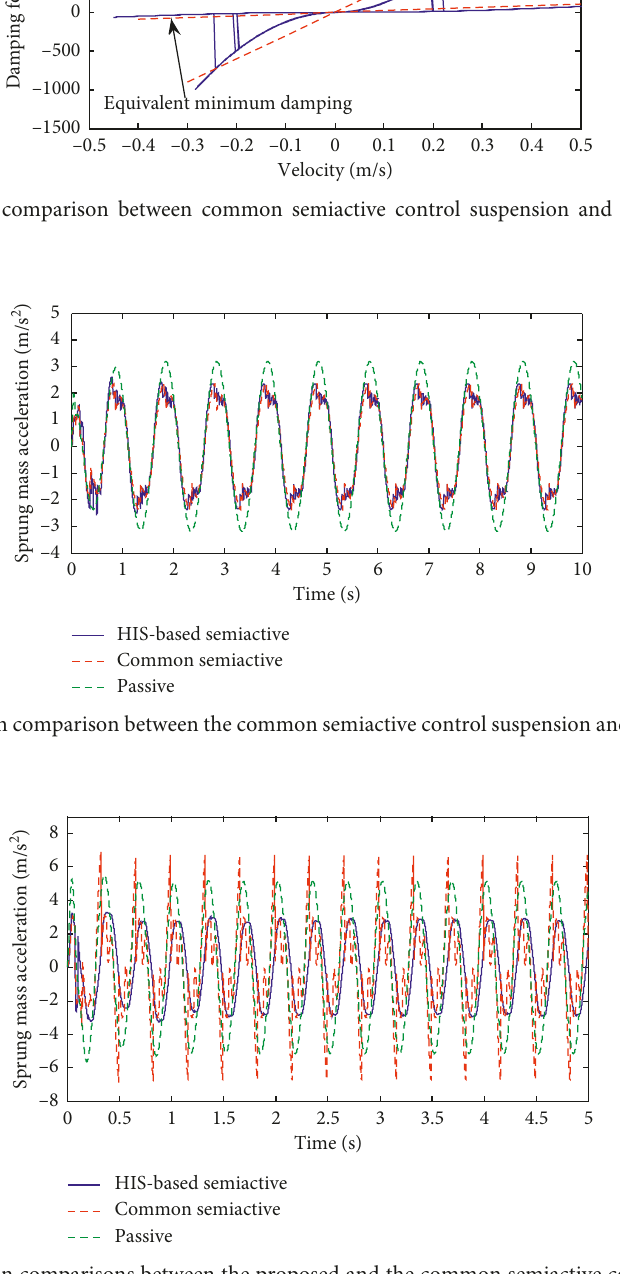
Figure 18: Body vertical acceleration comparisons between the proposed and the common semiactive control suspension under the road excitation period of 6 π .